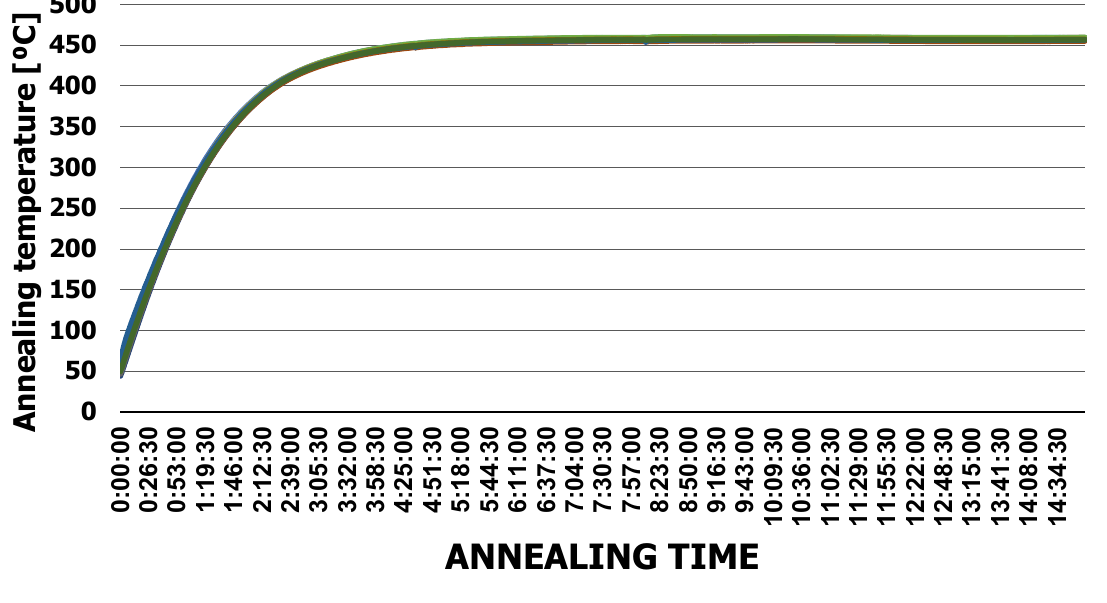
Figure 15. Temperature graph of the annealed die in the housing.